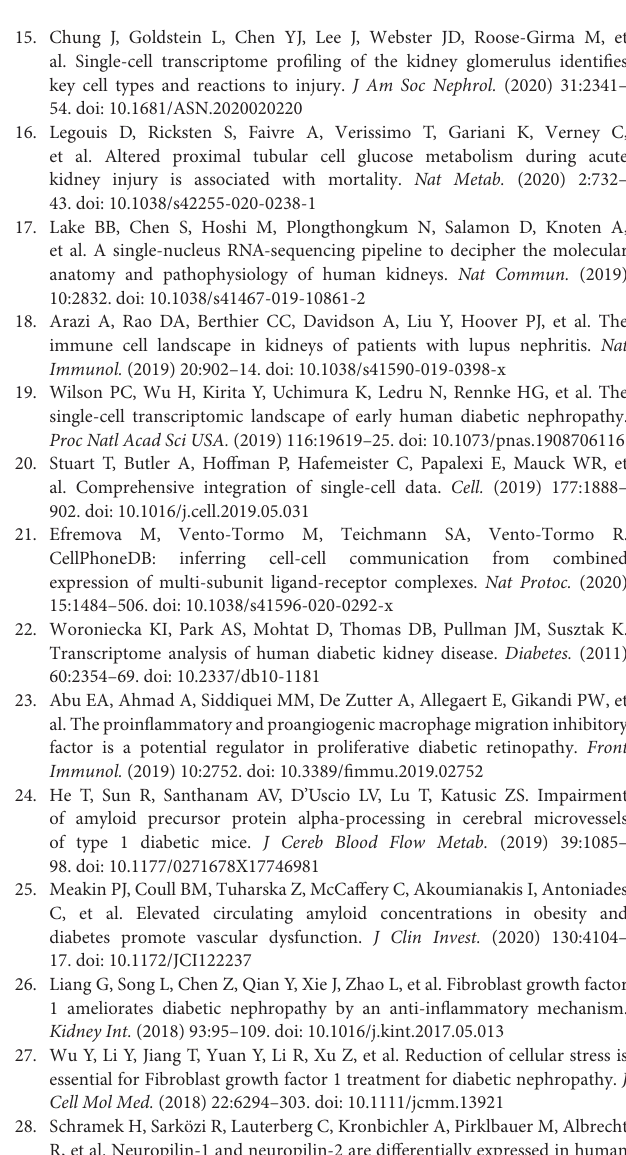
Supplementary Figure 1 | The expression of NRP1 in tubules. The protein levels of NRP1 in normal human kidneys were obtained from The Human Protein Atlas (A) . Tubular NRP1 is upregulated in DKD based on bulk sequencing data (B) . ∗∗∗ p < 0.001. Supplementary Figure 2 | The distribution and DEGs of IMC. The distribution of IMCs according to disease (A) and IFTA (B) is presented, and DEGs (DKD vs. nondiabetic control) in IMCs were calculated (C) . The dots in red represent upregulated genes, and the dots in blue represent downregulated genes. Supplementary Table 1 | Number of immune cells in each